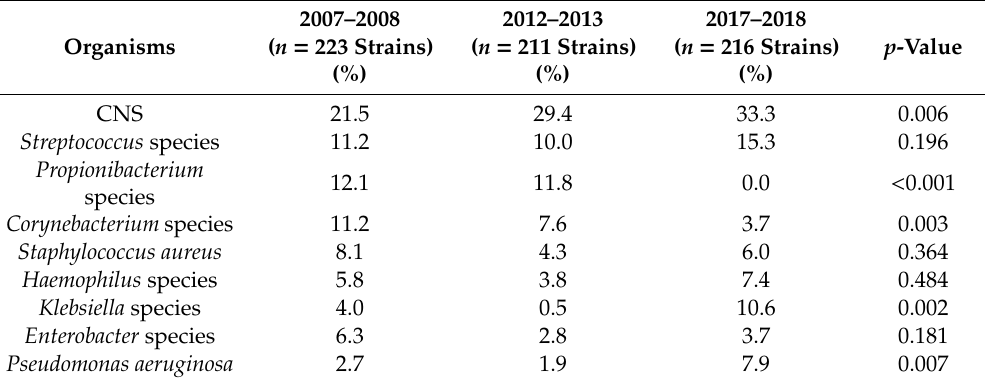
Table 5. Trends of frequently cultured bacteria over